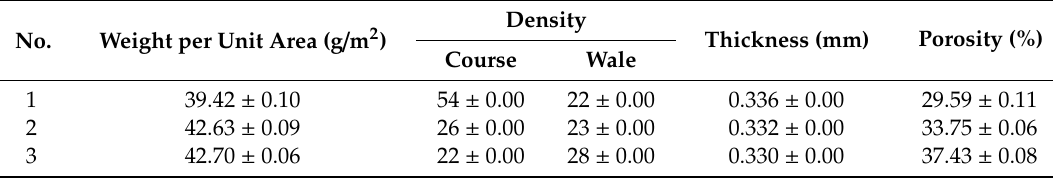
Table 3. Basic parameters of three kinds of fabrics.